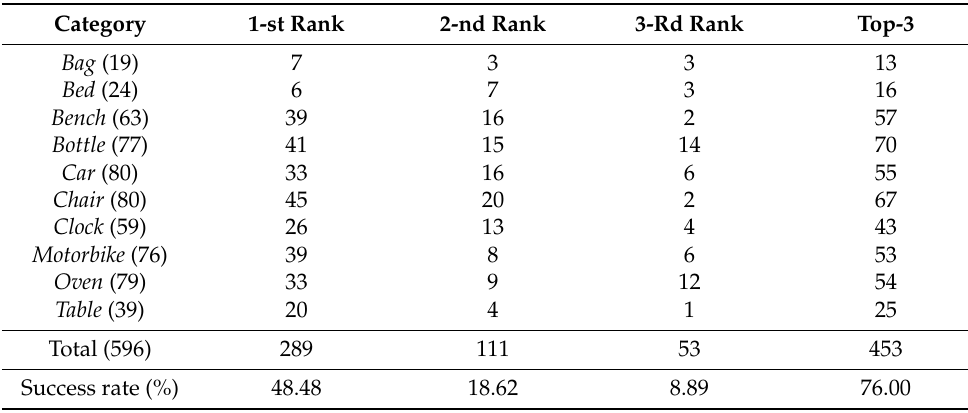
Table 2. CAD model retrieval results using the similarity measurement SM2.